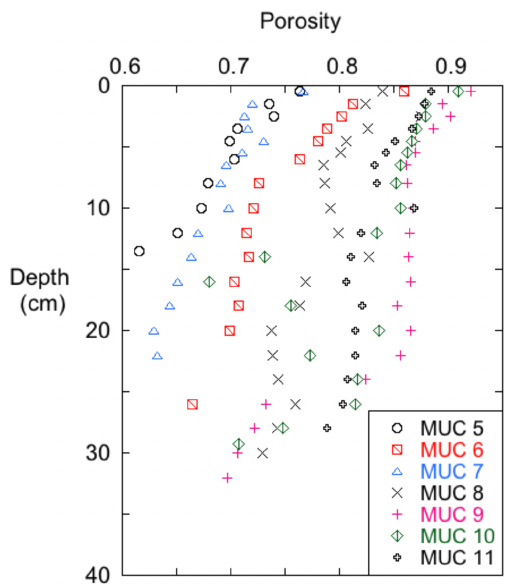
Figure 3. Porosity profiles for SMB 2016 MUC cores.